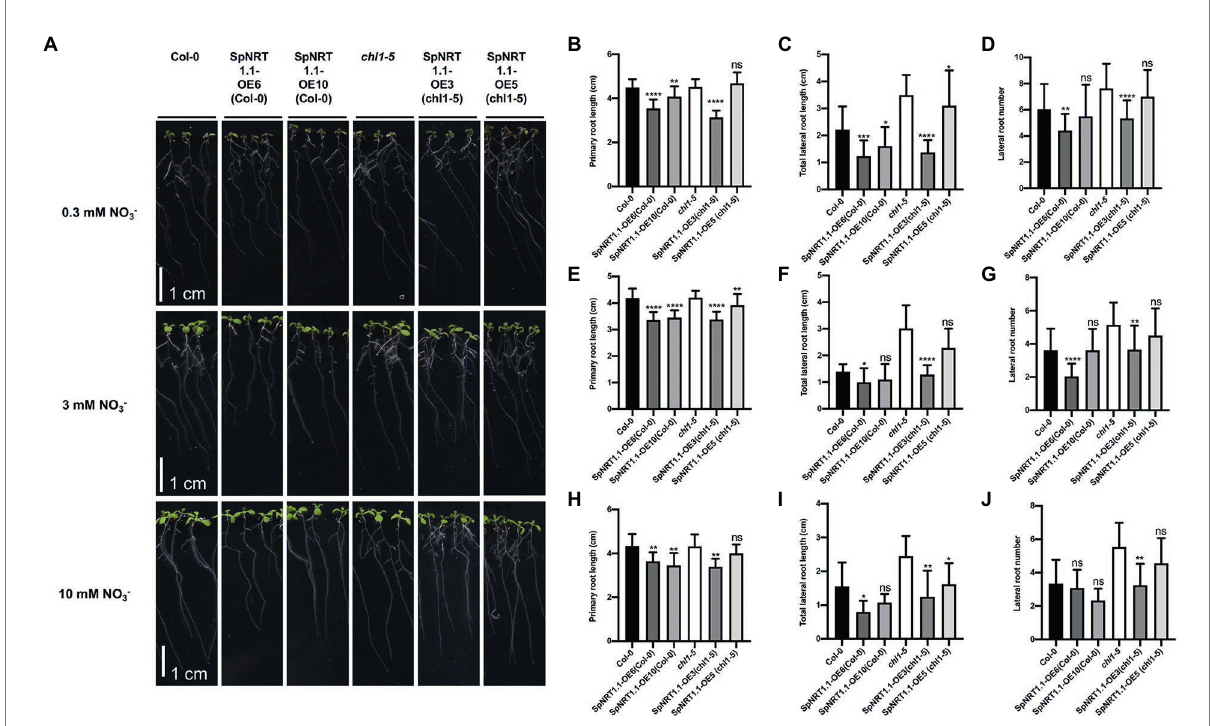
FIGURE 5 Overexpression of SpNRT1.1 in Col-0 and chl1-5 plants suppress primary and lateral root growth under different nitrate concentrations. (A) Phenotype of SpNRT1.1 overexpression lines and complemented lines under different nitrate-supplied concentrations. (B–J) Primary root length, lateral root number, and total lateral root lengths of SpNRT1.1 overexpression lines and complemented plants under 0.3 mm NO 3 − -supplied condition (B–D) , 3 mm (E,F) , 10 mm (H–J) . Student’s t -test was used for significant difference analysis. Asterisks indicate significance levels compared with chl1-5 mutant plants, * p < 0.05, ** p < 0.01, *** p < 0.001, **** p < 0.0001. n ≥ 10, Scale bar = 1